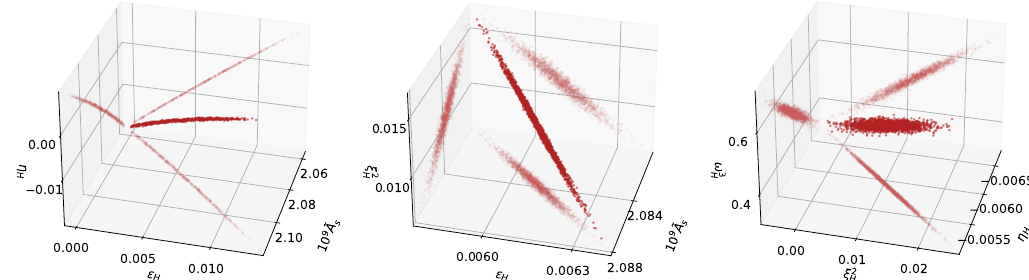
Figure 5: Sliced 3-dimensional likelihood ellipsoids for a selection of slow-roll pa- rameters from SKA